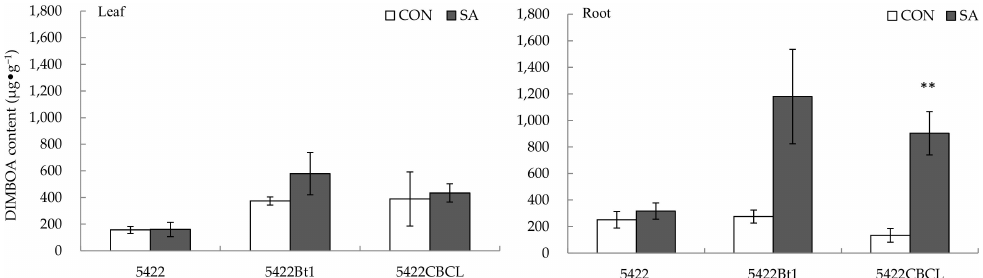
Figure 2. Direct and systemic effects of exogenous salicylic acid application to the aboveground part on the content of DIMBOA in leaves and roots of conventional and Bt corns. The data in the figure are means ± standard errors. Significance among the data was determined by paired Student’s t -test. “**” showed p < 0.01. CON: control; SA: salicylic acid; DIMBOA: 2,4-dihydroxy-7-methoxy-2H, 1,4-benzoxazin-3